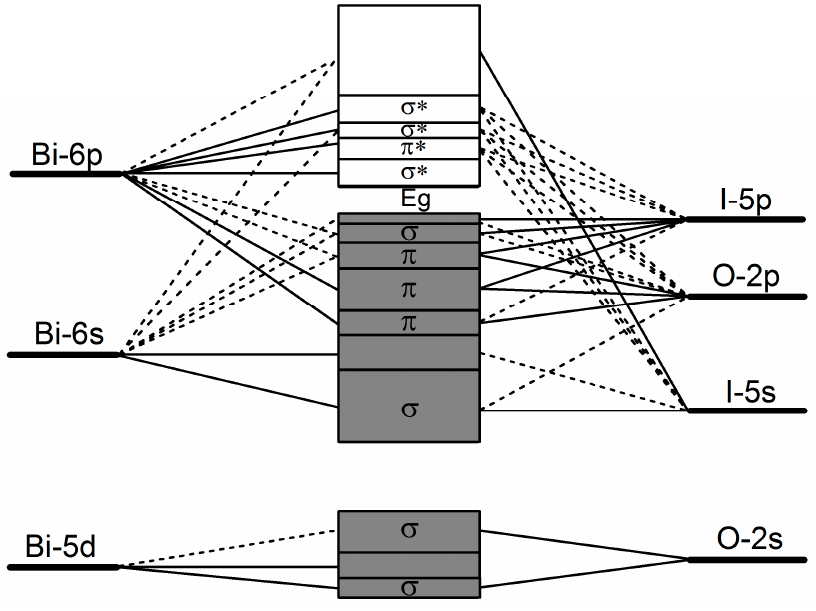
Figure 6. Proposed molecular ‐ orbital bonding diagram for BiOI. The solid and dashed lines represent large and small contributions, respectively. large and small contributions, respectively.